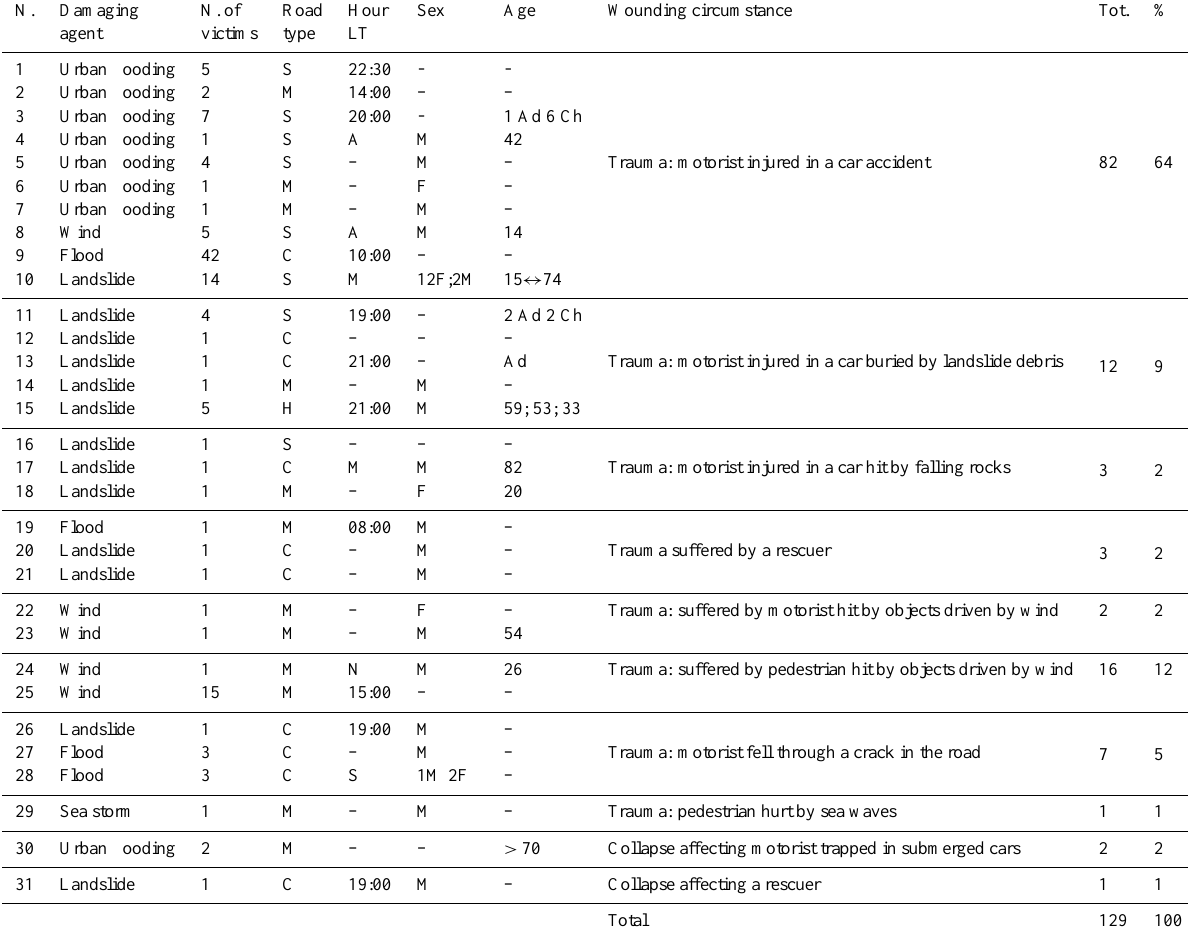
Table 3. Cases of injured. For each record, the following data are reported: damaging agent , number of injured, road type (H = Highway; S = State road; C = County road; and M = Municipal road), time at which the damage occurred (A = afternoon, M = morning, N = night, S = sunrise), (M=male; F=female), age (Ad=adult; Ch=child) and wounding circumstance.